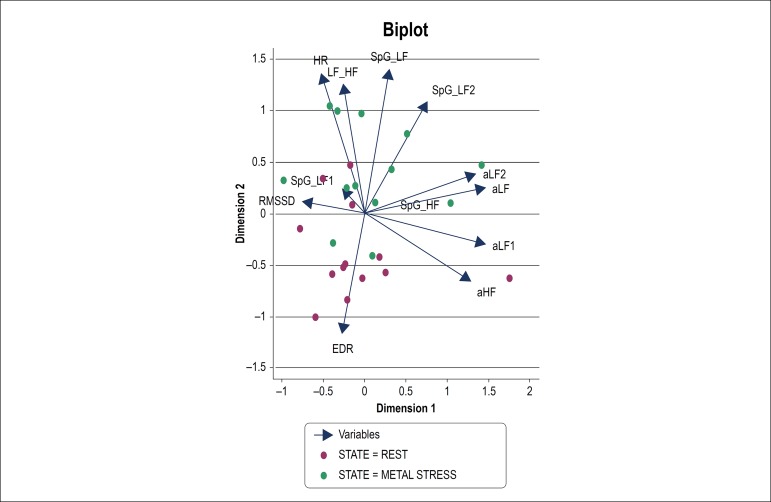
Principal Component Analysis of Traditional and Spectral Gini Indices of Heart Rate Variability during rest and mental stress (aHF = absolute HF; aLF1 = absolute LF1; aLF = absolute LF; aLF2 = absolute LF2). HR: heart rate; RMSSD: Root Mean Square of the Successive Differences; EDR: ECG-derived; Respiration Rate; LF: low frequency; HF: high frequency; SpG: spectral Gini coefficient.